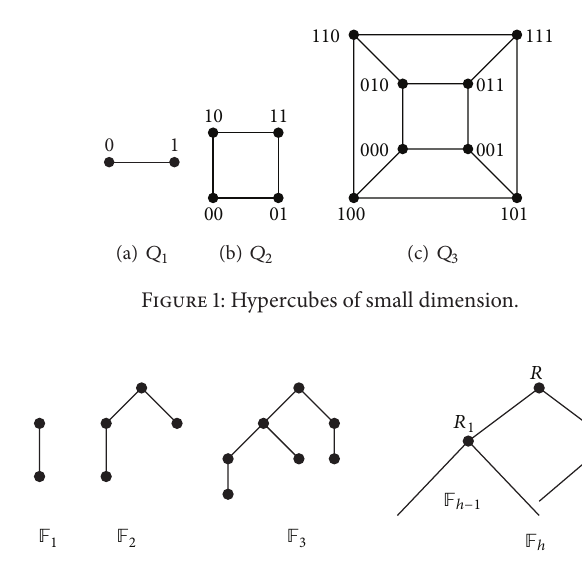
Figure 2: Examples of Fibonacci trees and recursive